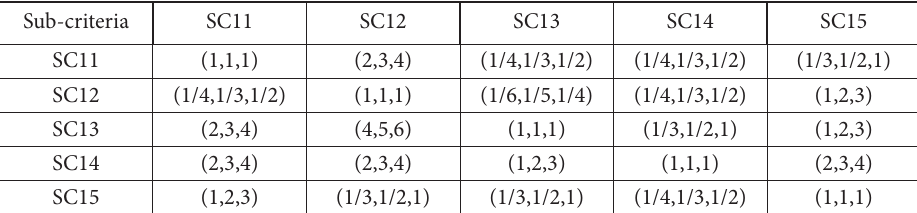
Table 4. Fuzzy comparison matrix for sub-criteria of MC1